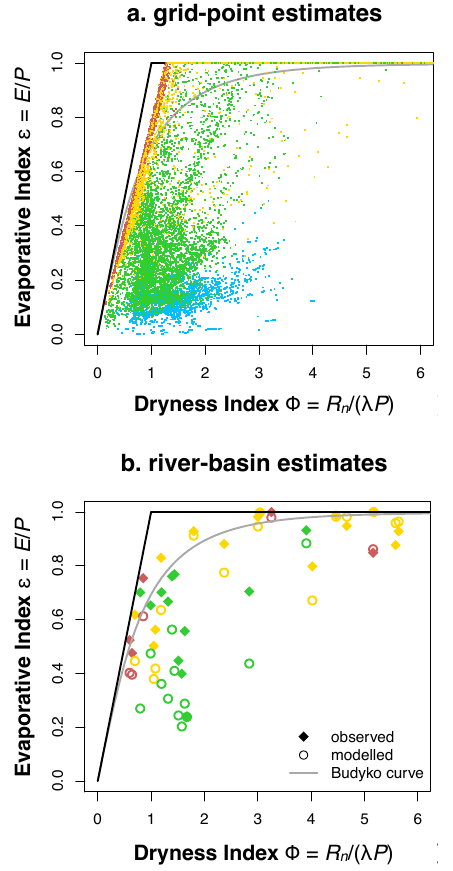
Figure 7. Comparison of the evaporative index derived from maxi- Fig. 7. Comparison of the evaporative index derived from maximum mum power to ERA-Interim data for (a) each grid cell and (b) av- power to ERA-Interim data for (a.) each grid cell and (b.) averaged eraged over major river basins. The color coding marks the geo- over major river basins. The color coding marks the geographic graphic location of the basins, as in Fig. 5. The grey line represents location of the basins, as in Fig. 5. The grey line represents the the Budyko curve, as in Fig. Budyko curve, as in Fig. 1.